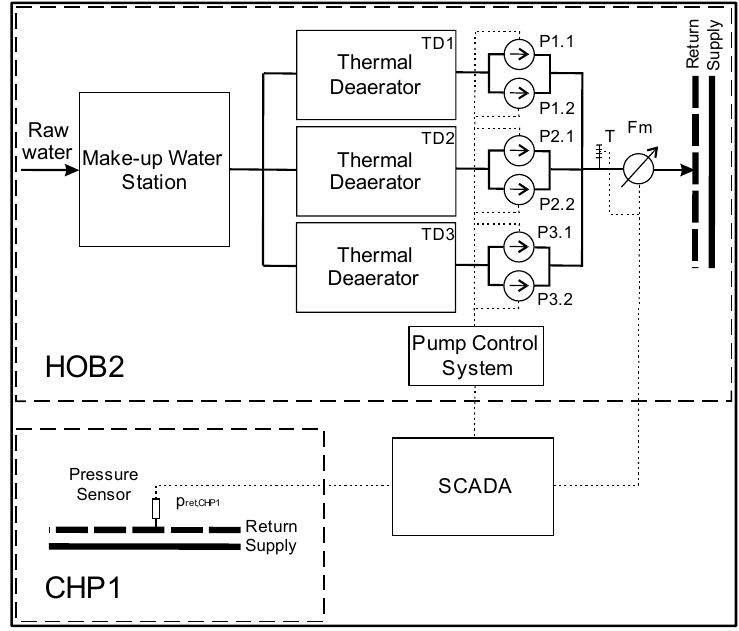
Figure 2. The diagram of make-up water station.